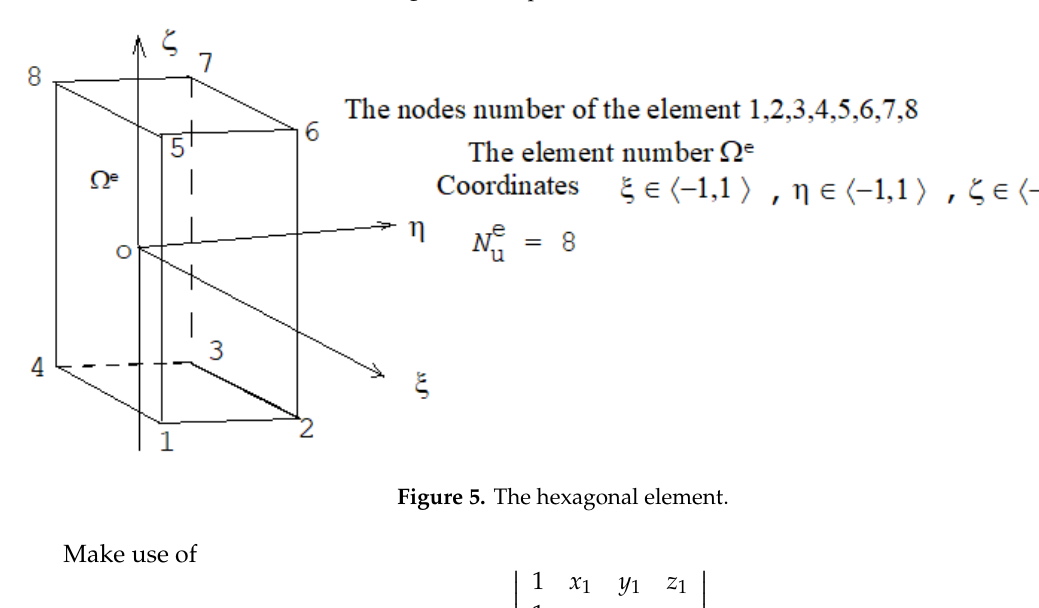
Figure 4. The pentahedral element.